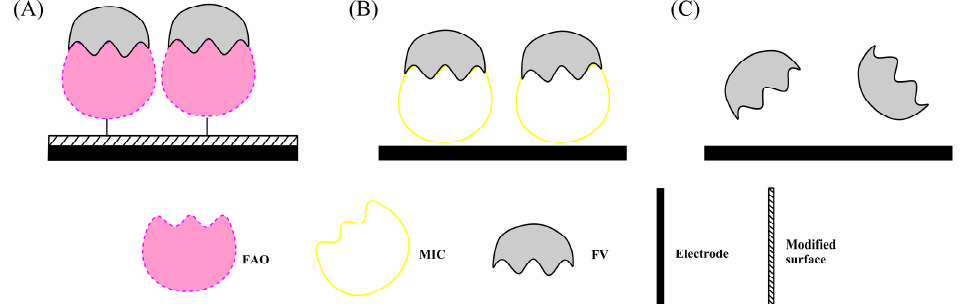
Figure 3. Schematic illustration of the construction of indirect HbA1c biosensors based on the recognition of fructosyl valine on the ( A ) PVA-SbQ or NPs modified electrode surface; ( B ) by MIC method; ( C ) by Non-enzymatic method.